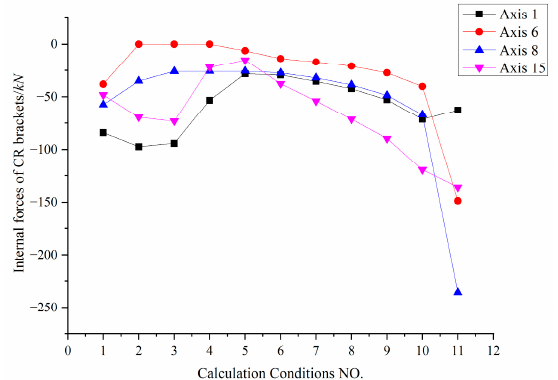
Figure 29. Internal force variation curves of four groups of typical external CR brackets.